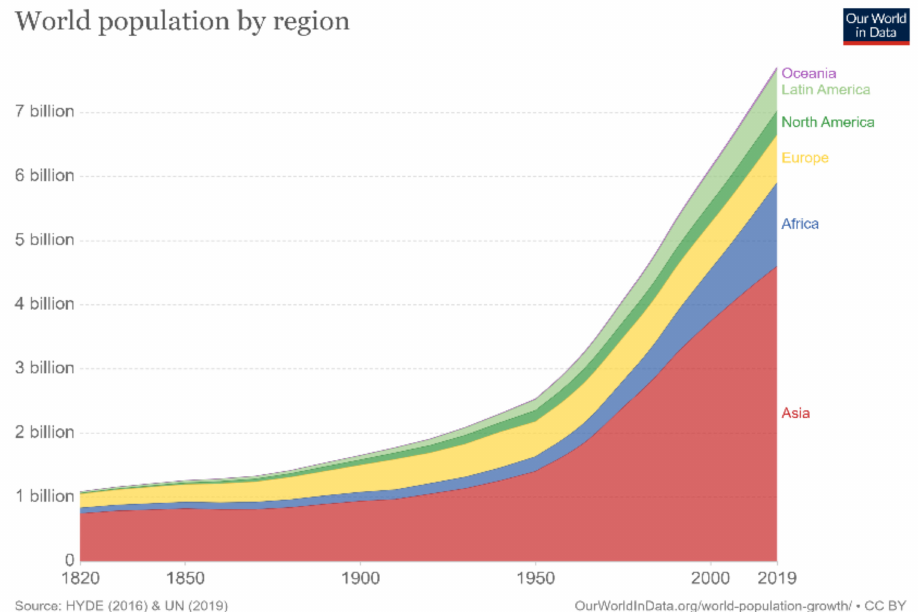
Figure 1. World population by region [1].